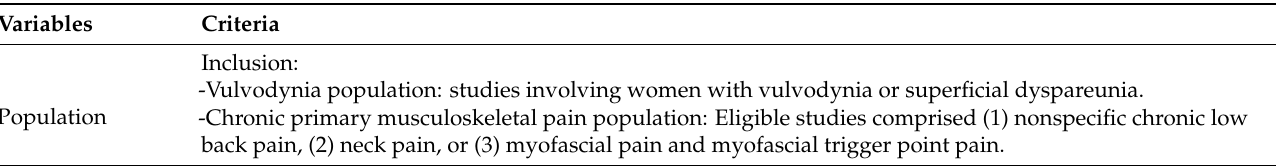
Table 1. Eligibility